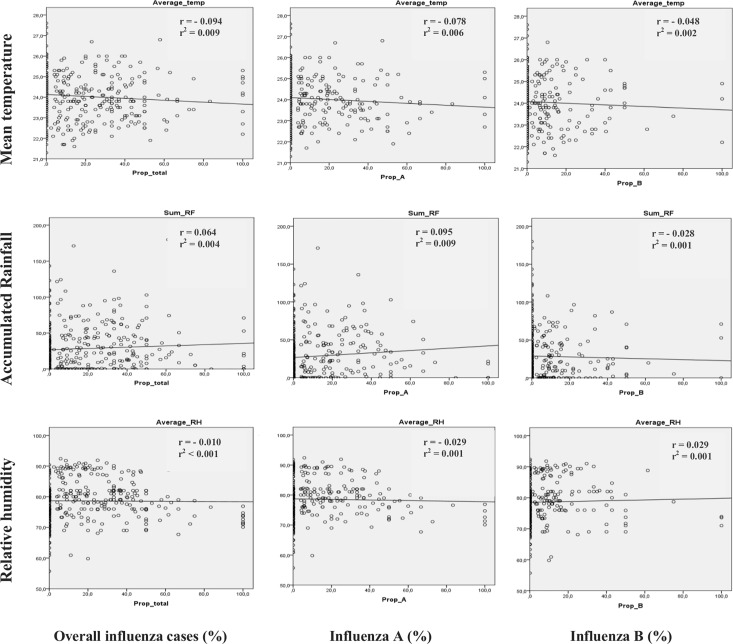
Curve estimation of relationship between influenza and weather variables.